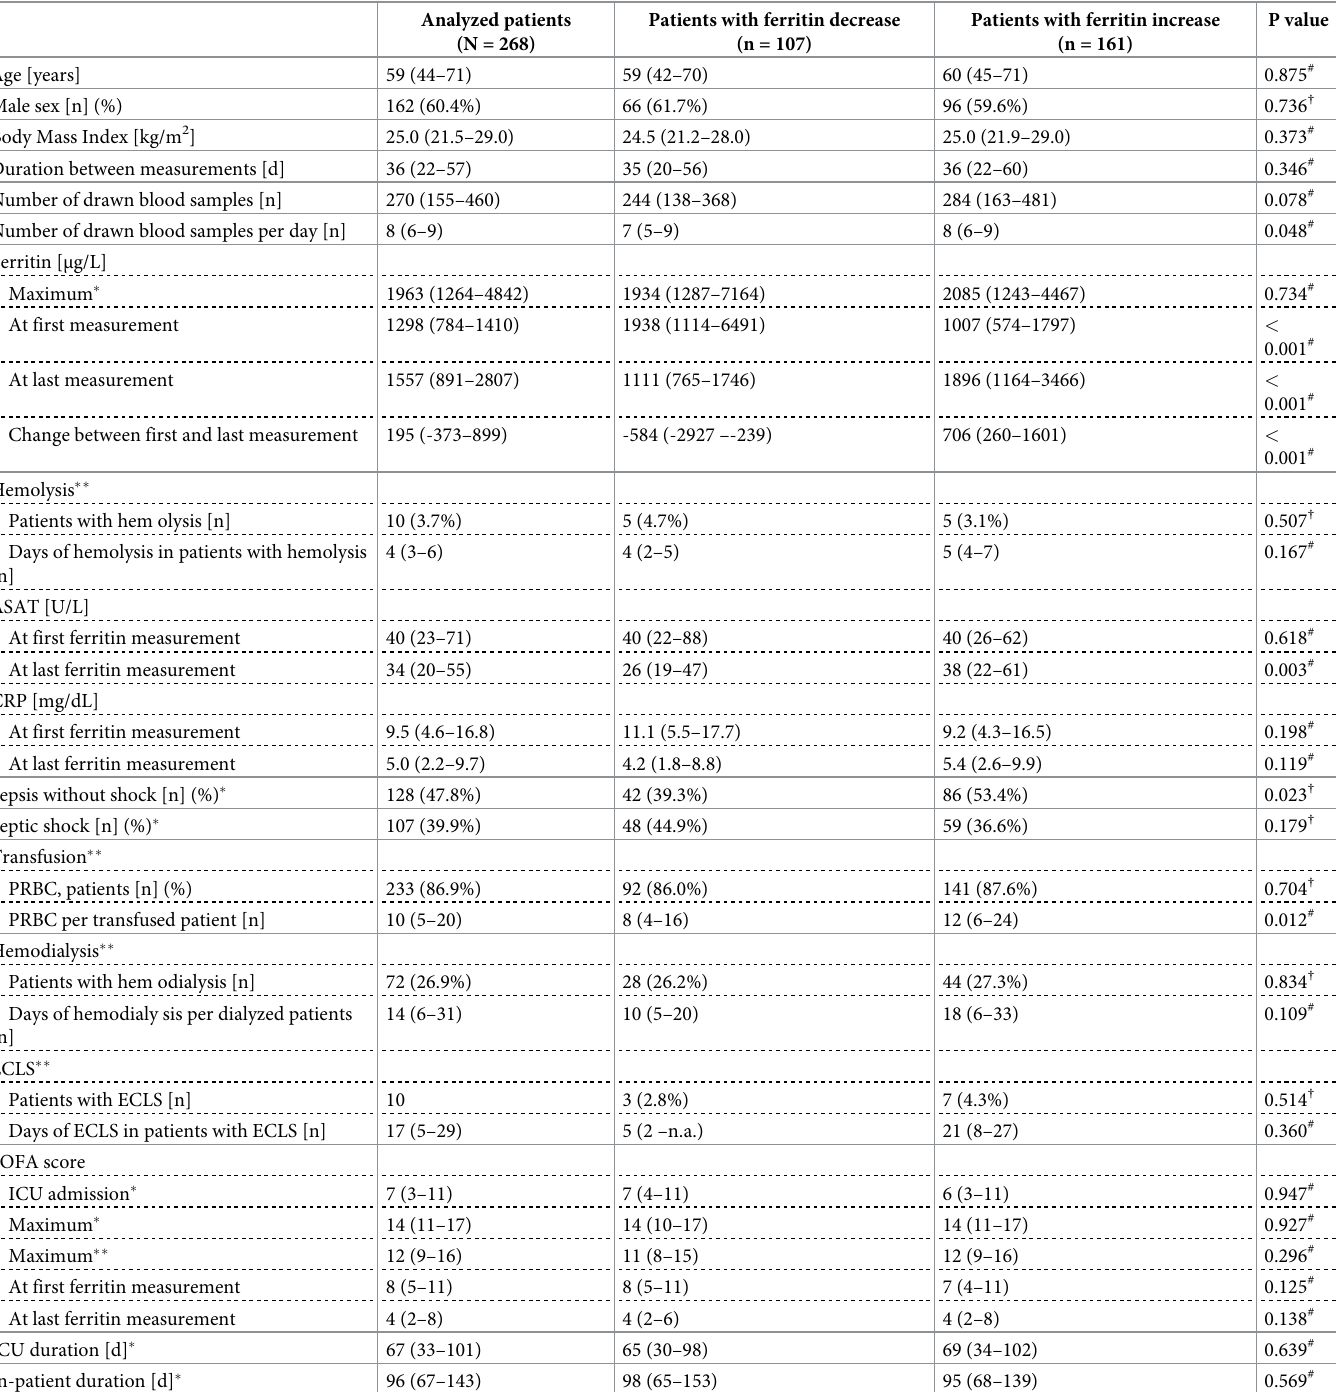
Table 1. Characteristics, ferritin values and outcome parameters over all patients and between patients with ferritin decrease and